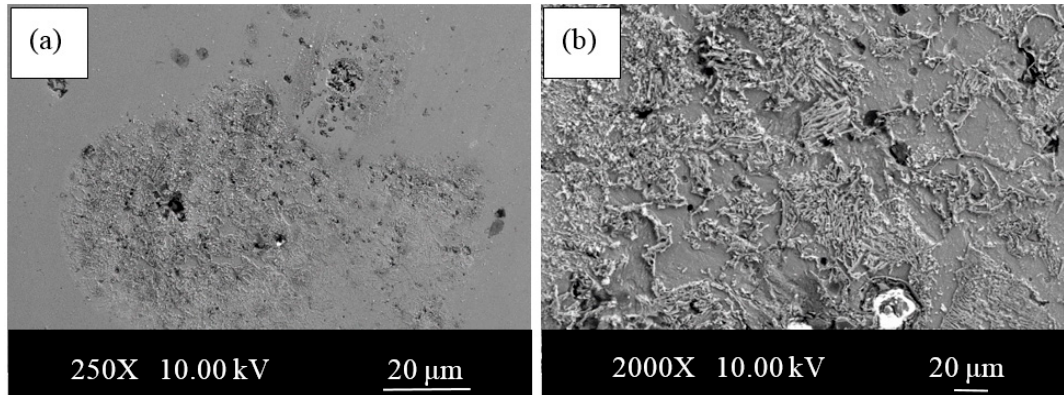
Figure 9. SEM images of the alloy 3-NbV-5Ni after corrosion ( a ) low and ( b ) high magnification.